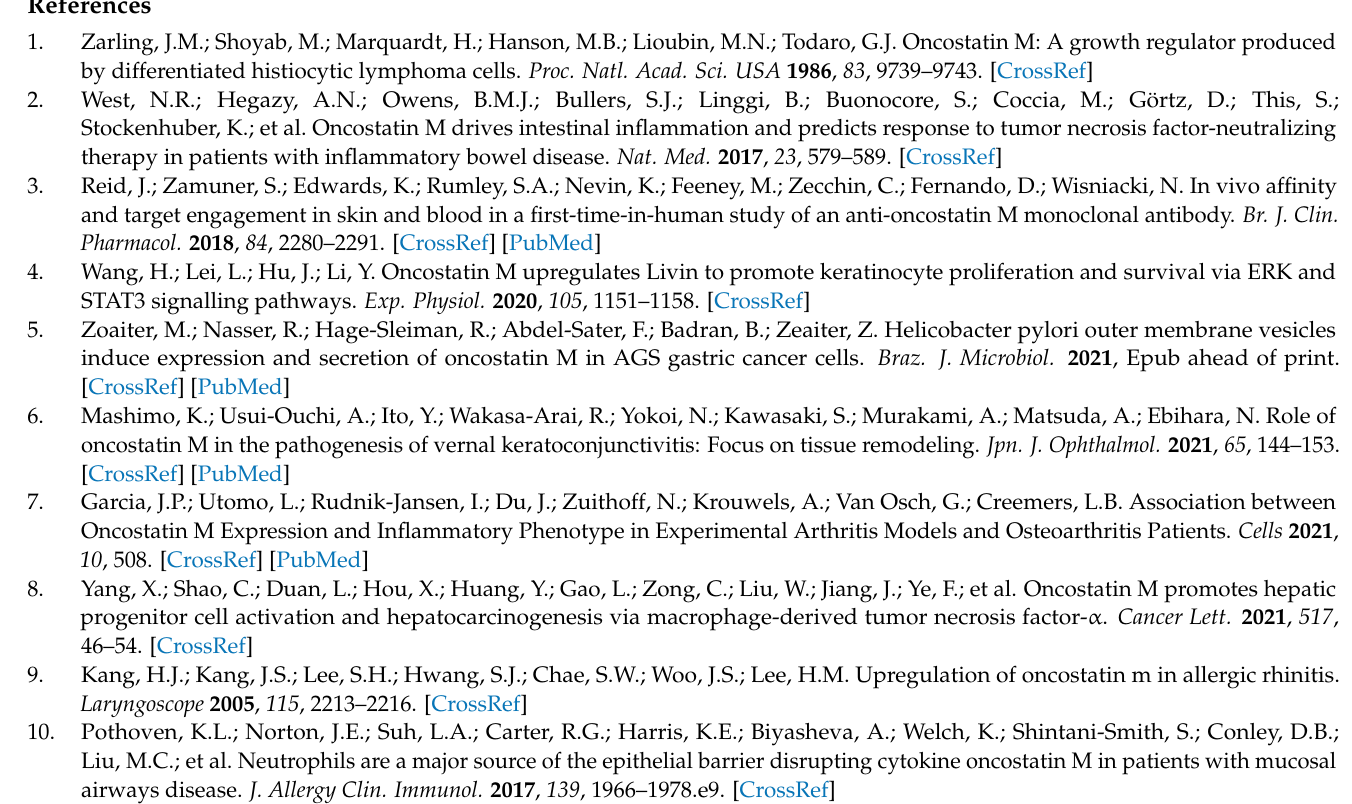
Supplementary Materials: Figure S1: Effects of Dex on the mRNA expressions of PI3K, Akt, and PI3K in neutrophil-like dHL-60 cells. Figure S2: IL-1 β production and effects of Dex in dHL-60 cells-conditioned medium (CM)-treated HaCaT cells. Figure S3: Experimental protocol for im- munofluorescence and IL-1 β